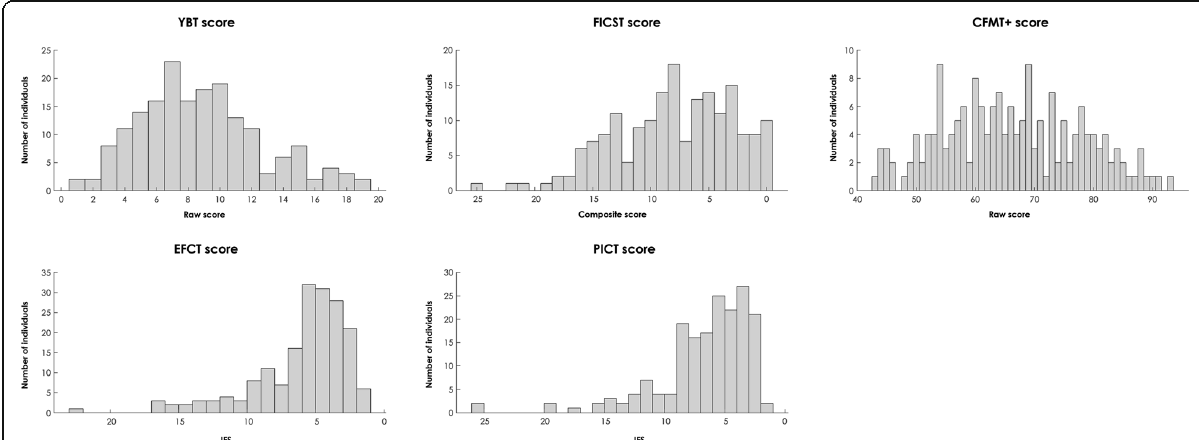
Fig. 3 Distributions of scores obtained for observers who participated in the Yearbook Test (YBT), Facial Identity Card Sorting Test (FICST), long form of the Cambridge Face Memory Test (CFMT+), Expertise in Facial Comparison Test (EFCT) and Person Identification Challenge Test (PICT). Note that scores representing low and high performance are represented on the left and right of the x axes, respectively (i.e., high inverse efficiency scores (IES) for the EFCT and PICT indicate low performance); for visualization purposes one extreme value was removed for the CFMT+ and PICT,